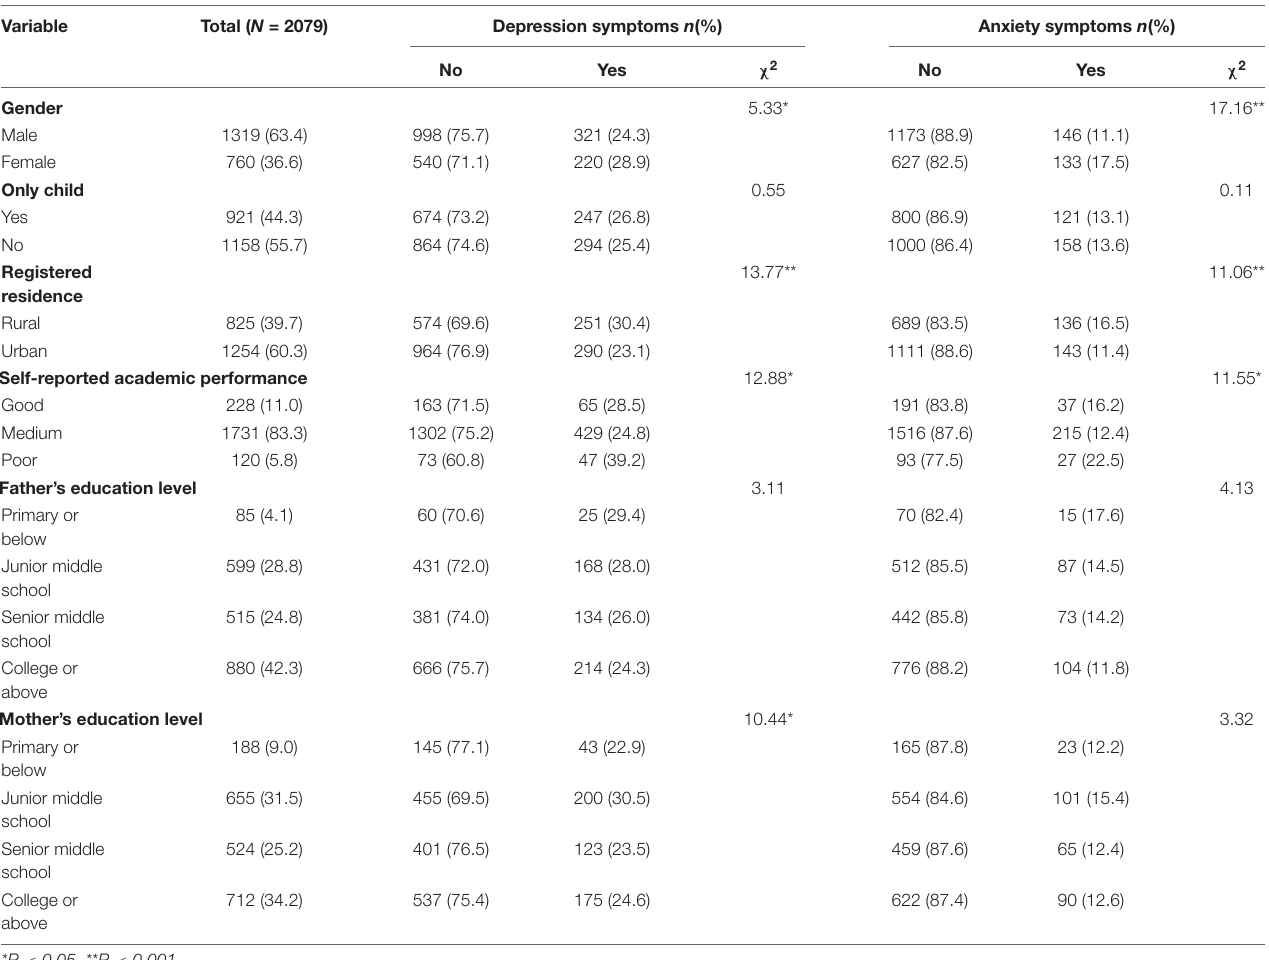
TABLE 1 | Characteristics of participants by depression/anxiety symptoms.